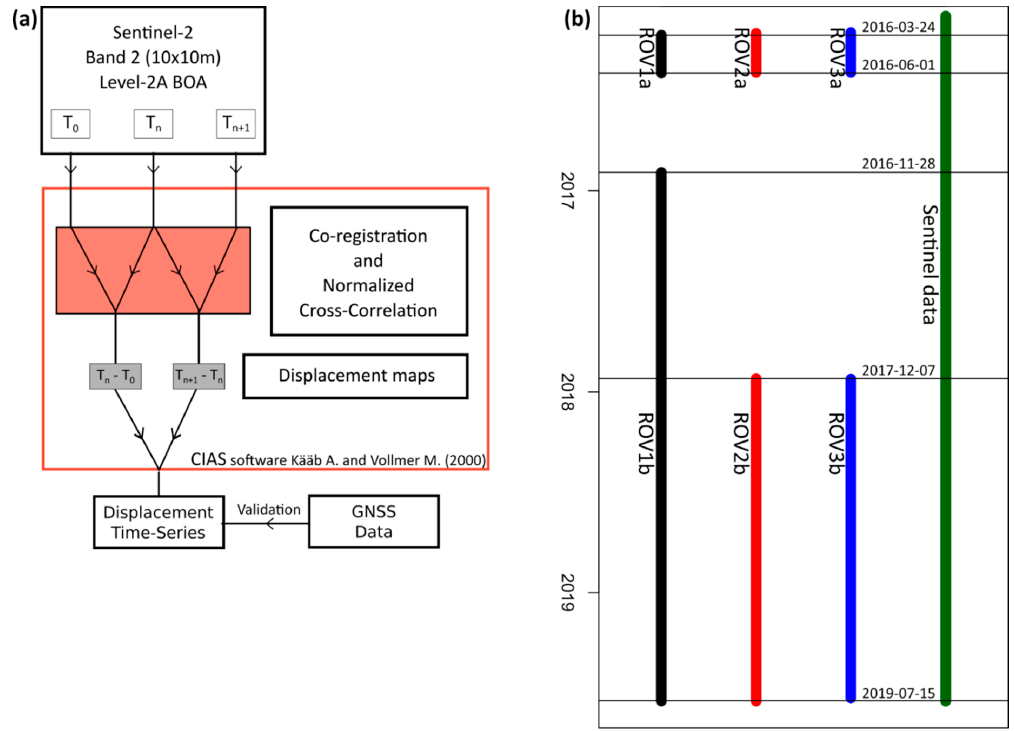
Figure 3. ( a ) Methodological workflow; ( b ) Temporal-coverage of Sentinel-2 and GNSS data in Ca’ Lita landslide.